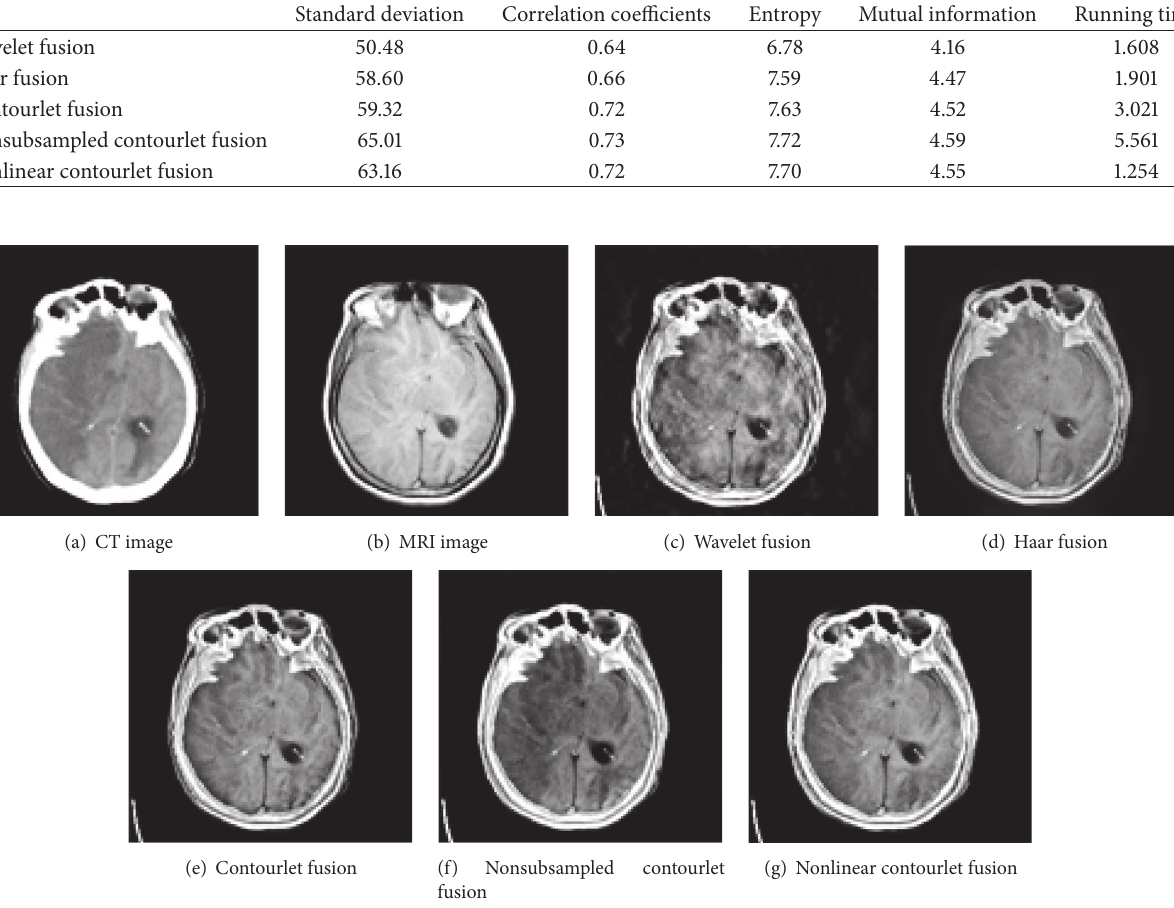
Table 3: Indexes of performance evaluation.